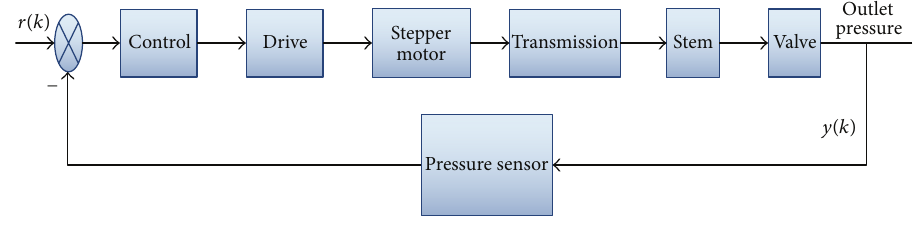
Figure 2: The principle diagram of electric gas pressure regulating